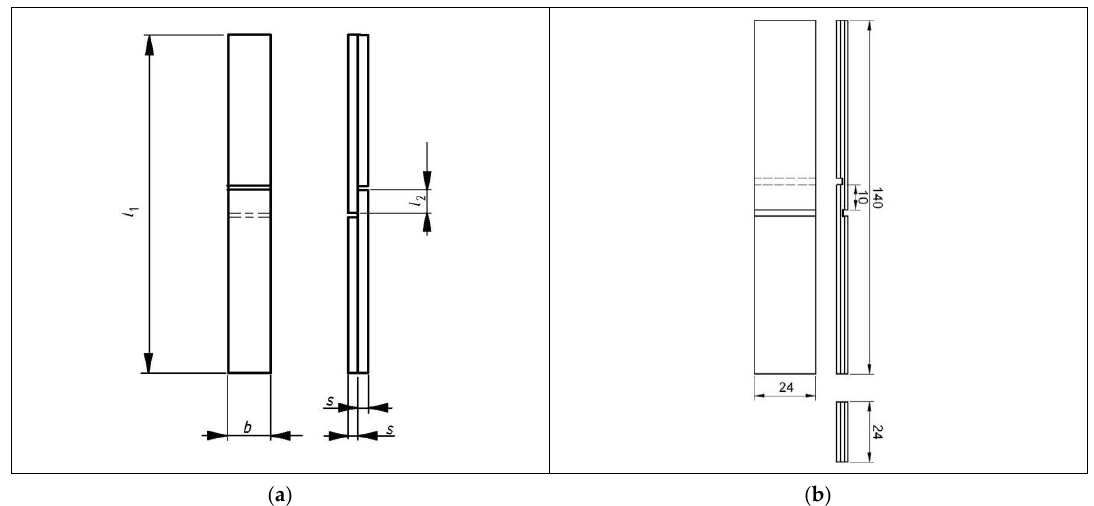
Figure 1. Bonding strength test samples: ( a ) for the bond strength in longitudinal tensile shear strength according to EN 302 ( l 1 —length of the test specimen; l 2 —length of the overlap (length of the surface to be tested); b —width of the test specimen (width of the surface to be tested); s —thickness of the veneer) ( b ) for the shear strength according to EN